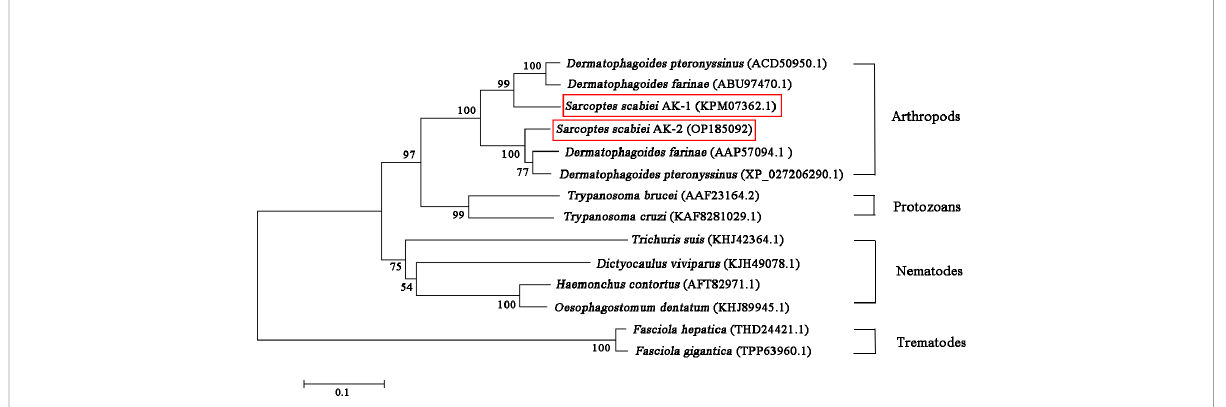
FIGURE 2 Phylogenetic relationships between SsAKs and other species. The AK amino acid sequences of 11 species were selected and the phylogenetic tree was constructed by NJ. The AK sequence accession numbers of each species are as follows: SsAK-1 (KPM07362.1), SsAK-2 (OP185092), D. farina (ABU97470.1), D. pteronyssinus (ACD50950.1), D. pteronyssinus (XP 027206290.1), D. farina (AAP57094.1), H. contortus (AFT82971.1), Trichuris suis (KHJ42364.1), Dictyocaulus viviparus (KJH49078.1), Oesophagostomum dentatum (KHJ89945.1), Fasciola hepatica (THD24421.1), F. gigantica (TPP63960.1), T. brucei (AAF23164.2), T. cruzi (KAF8281029.1).